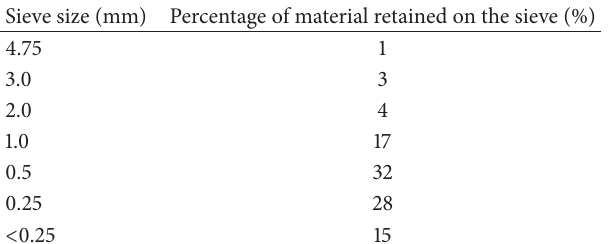
Table 1: Feedstock particle size distribution for production of bri- quettes.